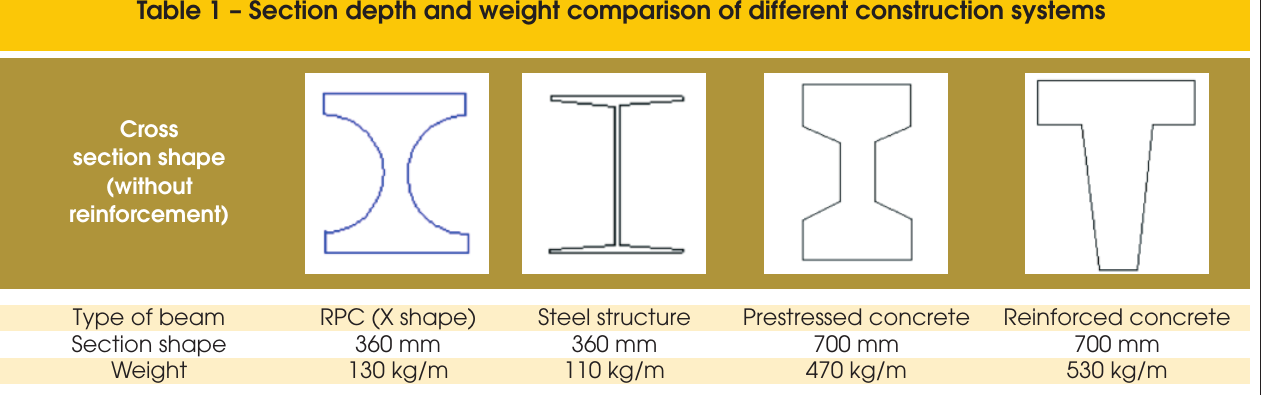
Type of beam Section